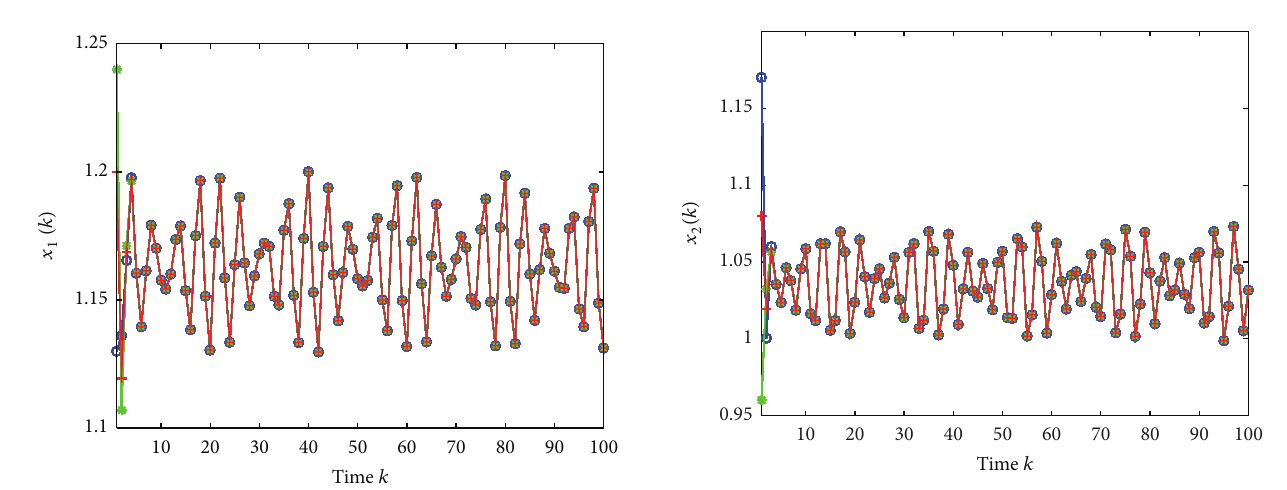
Figure 2: Dynamic behavior of the second component 𝑥 2 (𝑘) of the solution (𝑥 1 (𝑘),𝑥 2 (𝑘),𝑥 3 (𝑘)) to system (74) with the initial conditions (1.13, 1.17, 1.2) , (1.24, 0.96, 0.95) , and (1.2, 1.08, 1.14) for 𝑘 ∈ [1,100] , respectively.